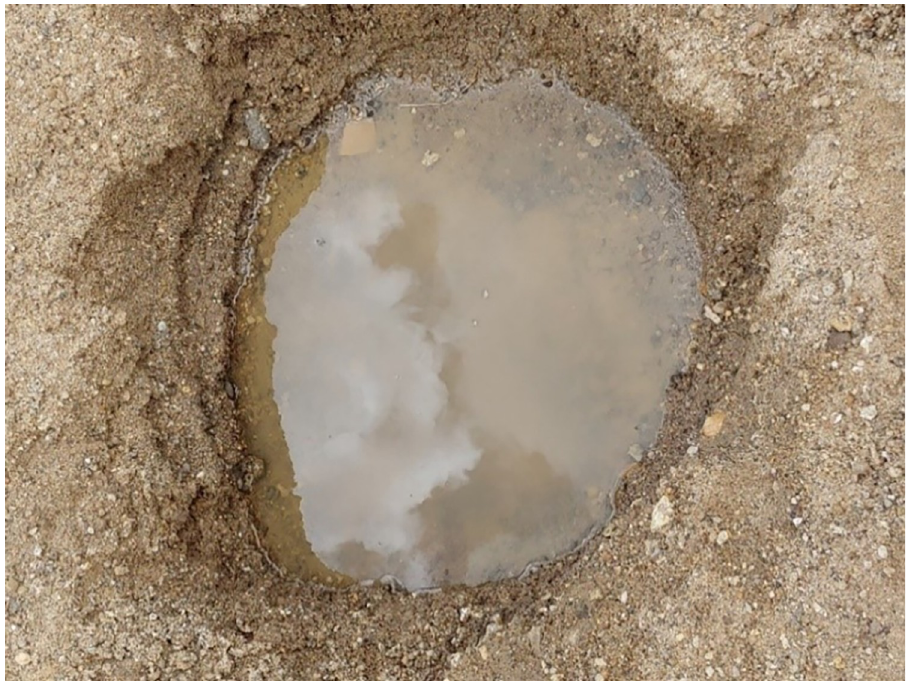
Fig 5. Best alternative water sources that served the community in Natapar Kocuc village following the vandalization of the only available safe water source in the village. A number of such small ponds were dug by the community along the bed of a seasonal stream. Note the dirty water and the water